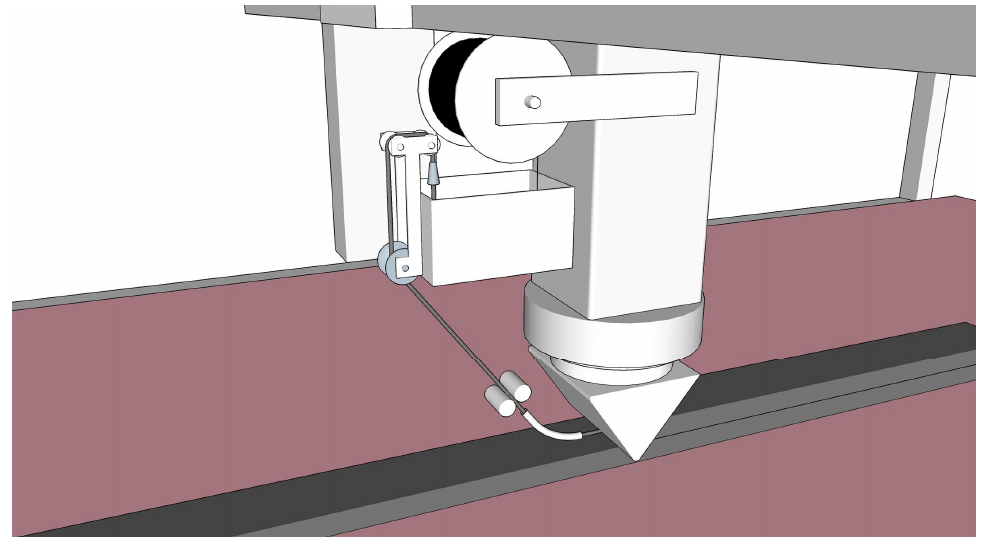
Figure 4. 3D concrete printing with MCF supplied from a mobile impregnating device.